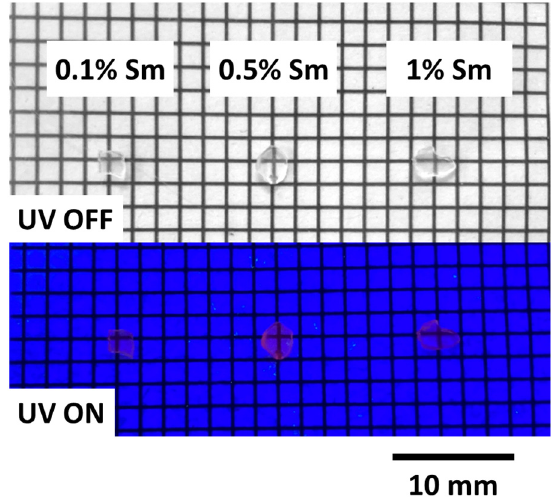
Figure 1. Photographs of Sm:SrCl 2 .